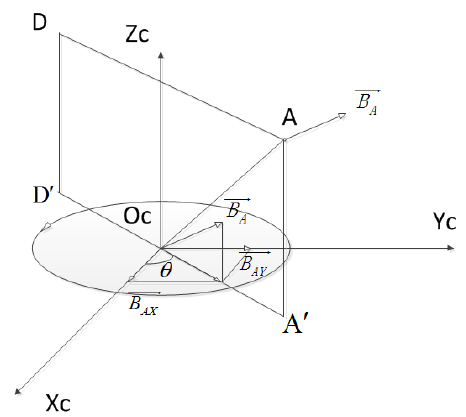
Figure 6. Analyzing on errors of